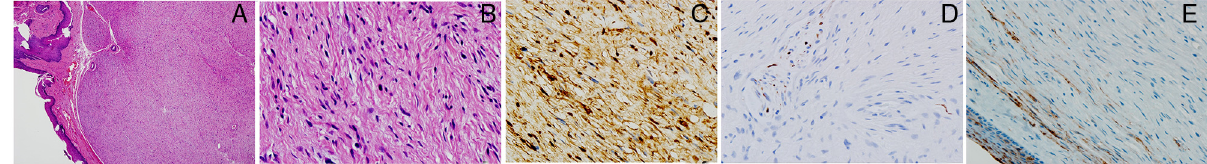
Figure 1 Neoplasia with well-defined limits, consisting of spindle cells arranged in fascicles with undulated nuclei without atypia (A and B). Immunocytochemical analysis: C, S-100 protein (PS-100) --- diffusely positive spindle cells; D, neurofilaments (NFs) --- positive intratumoral axons for NFs; E, EMA --- partially encapsulated neoplasia. Capsule positive for epithelial membrane antigen